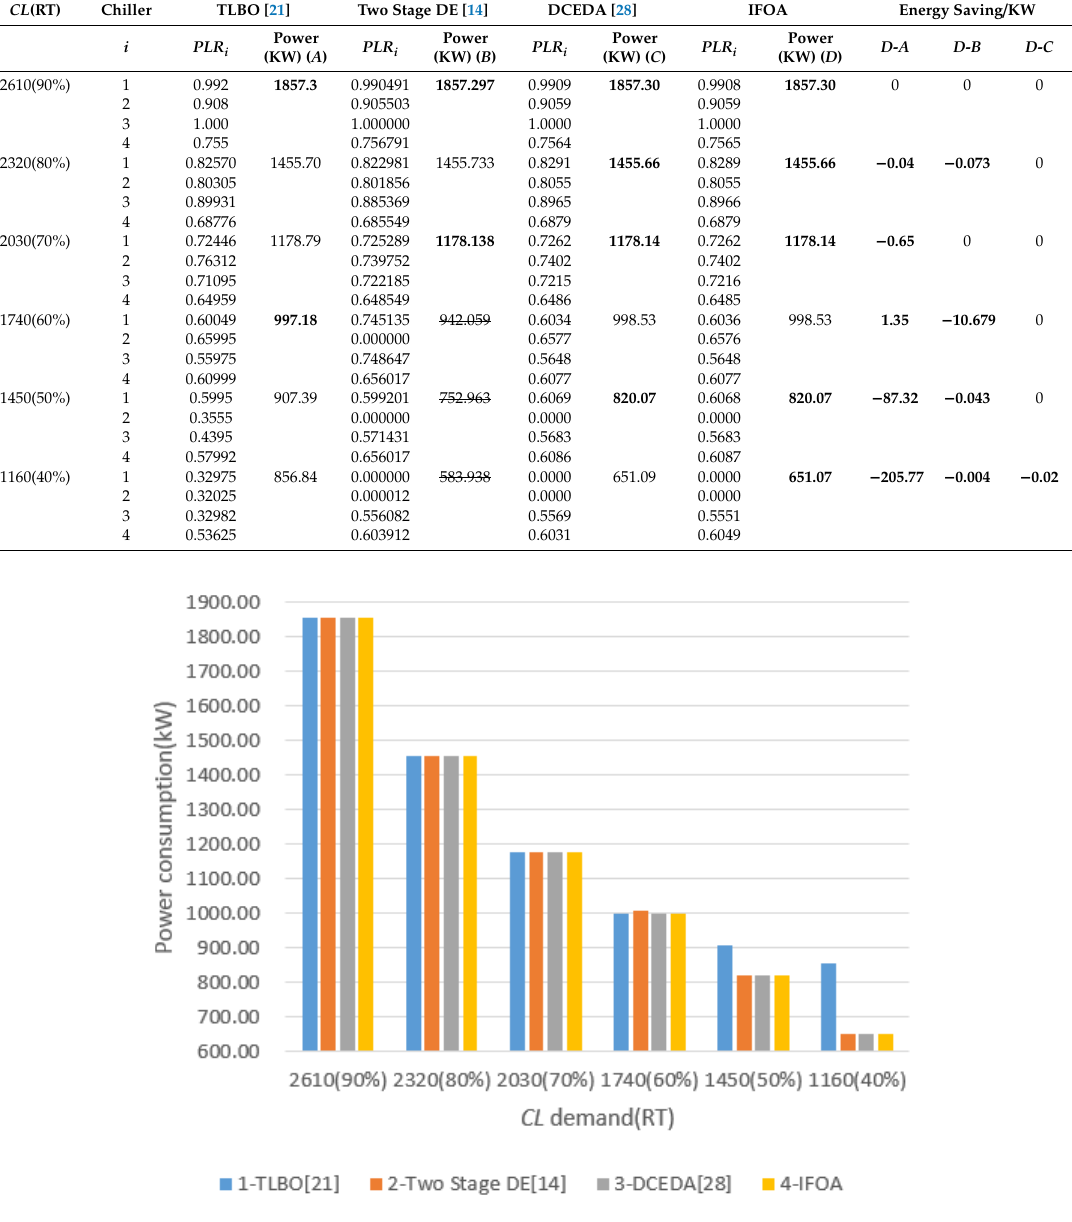
Table 7. The energy conservation of IFOA compared with TLBO, Two Stage DE, and DCEDA in case 2. CL (RT)